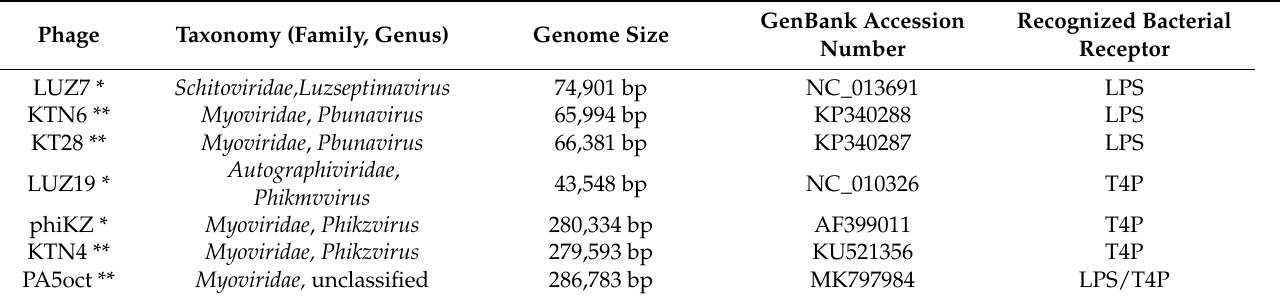
Table 1. Detailed characteristics of the bacteriophages used in this work.